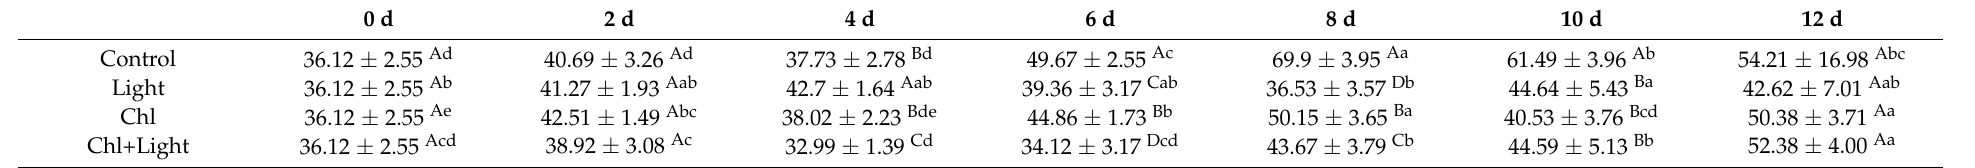
Table 1. L* value of samples during storage.